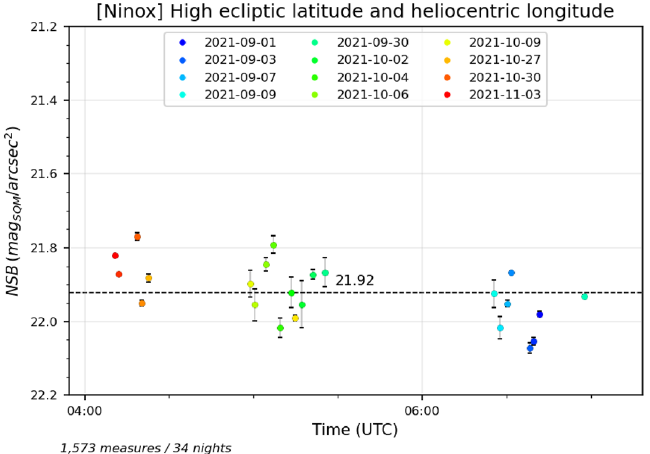
Figure 7. Measures obtained during moonless nights with good clear sky conditions where (1) the galactic latitude absolute value is greater than 70 ◦ (2) the ecliptic latitude of the zenith is greater than 30 ◦ or lower than − 30 ◦ (3) the zenith helioecliptic longitude is greater than 160 ◦ . This corresponds to situations where the zenith is far from the Galactic plane and also far from the ecliptic plane with higher angular distances from the Sun than in Fig. 6.